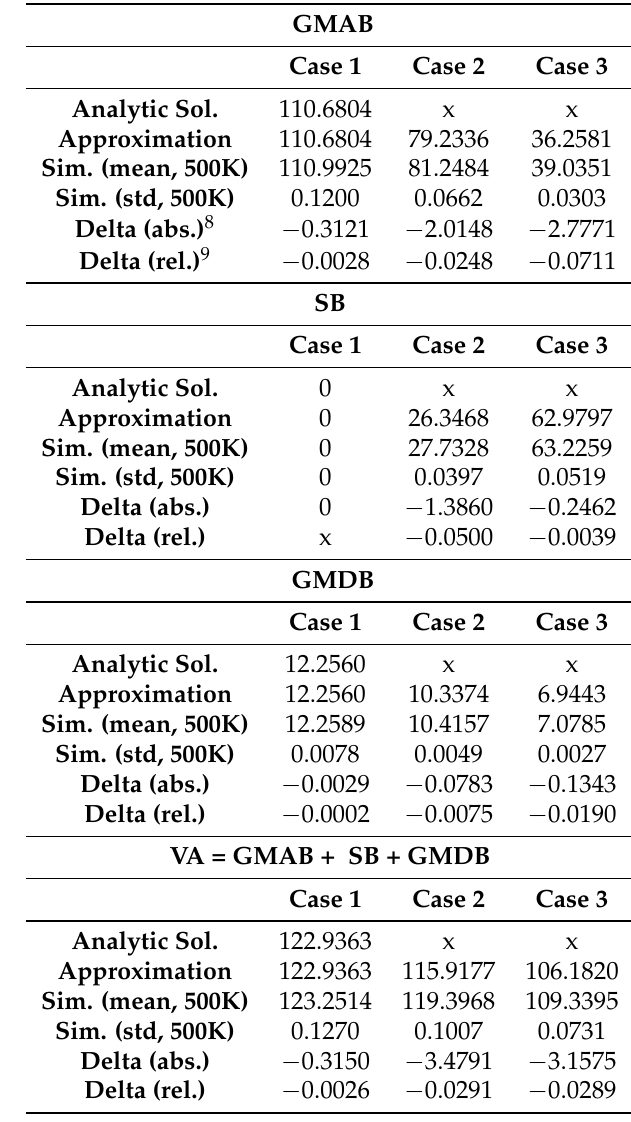
Table 7. VA Prices, Standard Deviations and